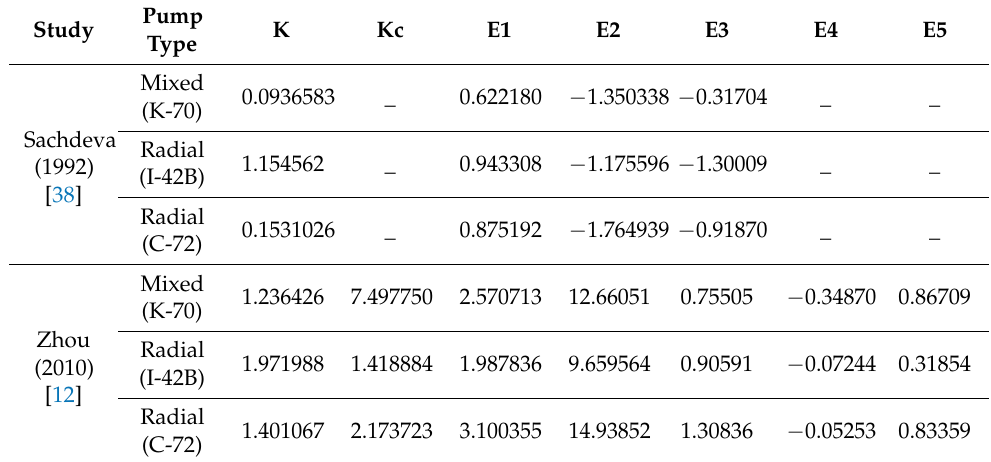
Table 3. The values of correlation coefficients for mixed-flow pump K-70.